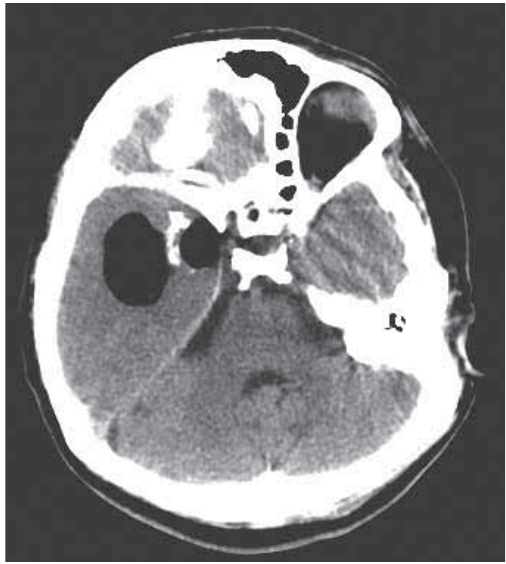
FIGURE 1. Brain CT of dermoid cyst in right temporabasal region.